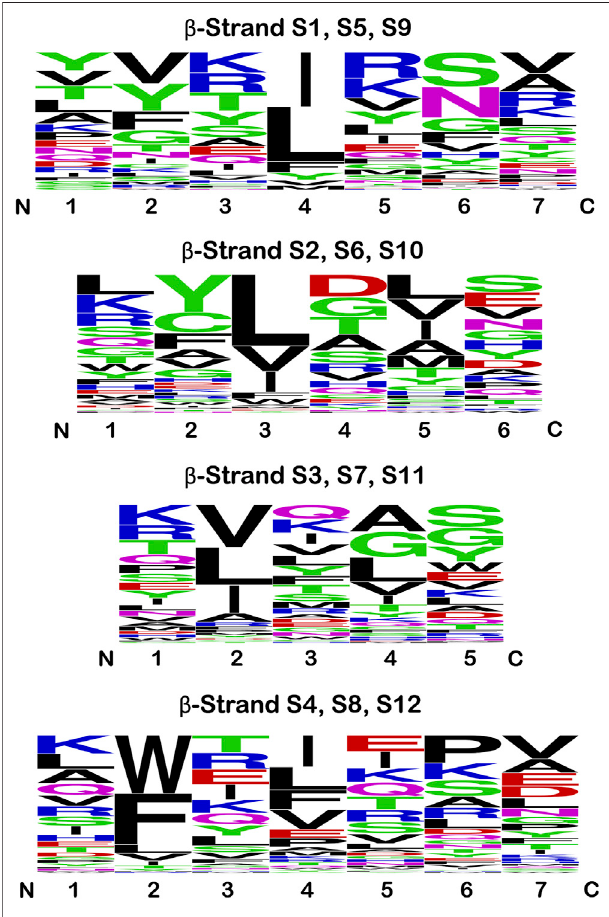
FIGURE 6 | Sequence logo plots for the β -strand secondary structure in the β -trefoilsuperfamily.Equivalent β -strands aregrouped bytheC 3 rotational symmetry of the β -trefoil for all members of the superfamily in Table 1 . Thus, strands S2, S6, and S10 are grouped together in this analysis, and similarly for the other symmetry-related β -strands (therefore, n = 126 at each position). The single letter amino acid code is utilized, and the height indicates the relative prevalence of a particular amino acid at each position. The amino acids are colored according to chemical properties (see text); however, hydrophobic is indicated by